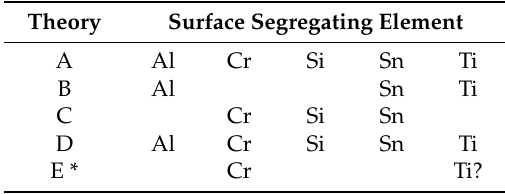
Table 7. Solutes in Nb-X segregating to the surface. Theory Surface Segregating Element A Al Cr Si Sn